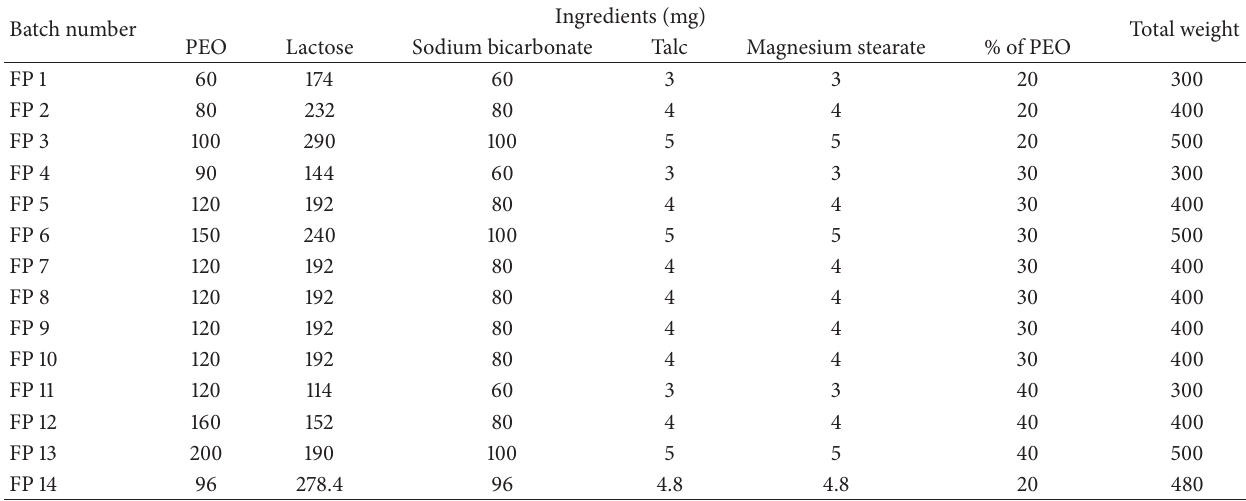
Table 2: Composition of coat for floating pulsatile release